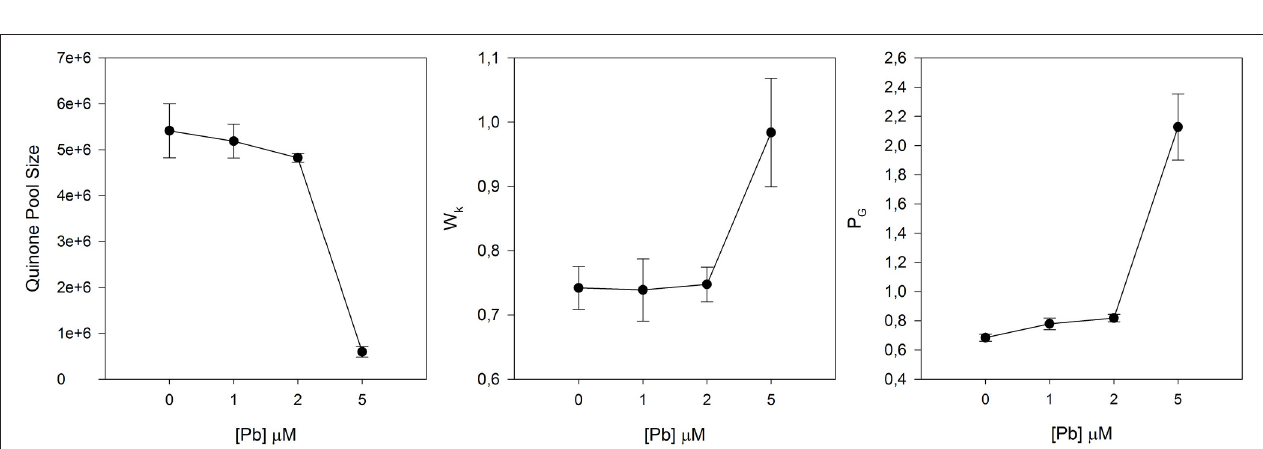
FIGURE 5 | Quinone pool size, oxygen evolving complexes (OECs) damage (W k ), and Grouping probability (P G ) in Juncus accutus exposed to increased doses of lead (Pb). Data is presented as average ± standard